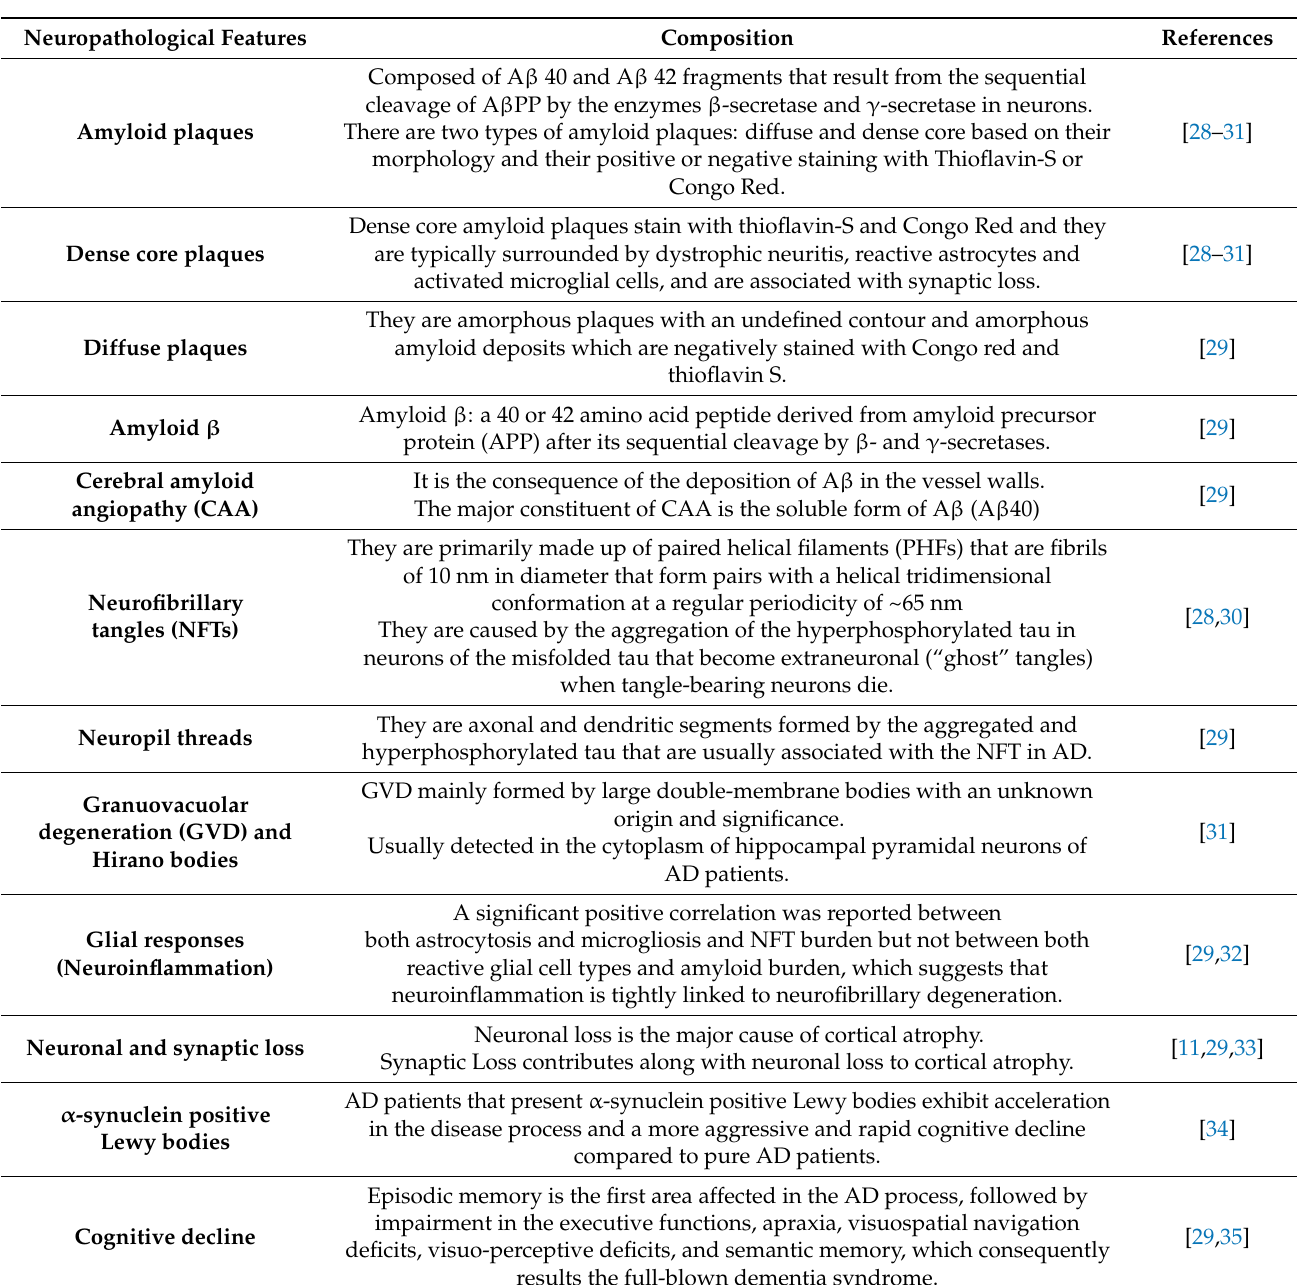
Table 1. Neuropathological features of